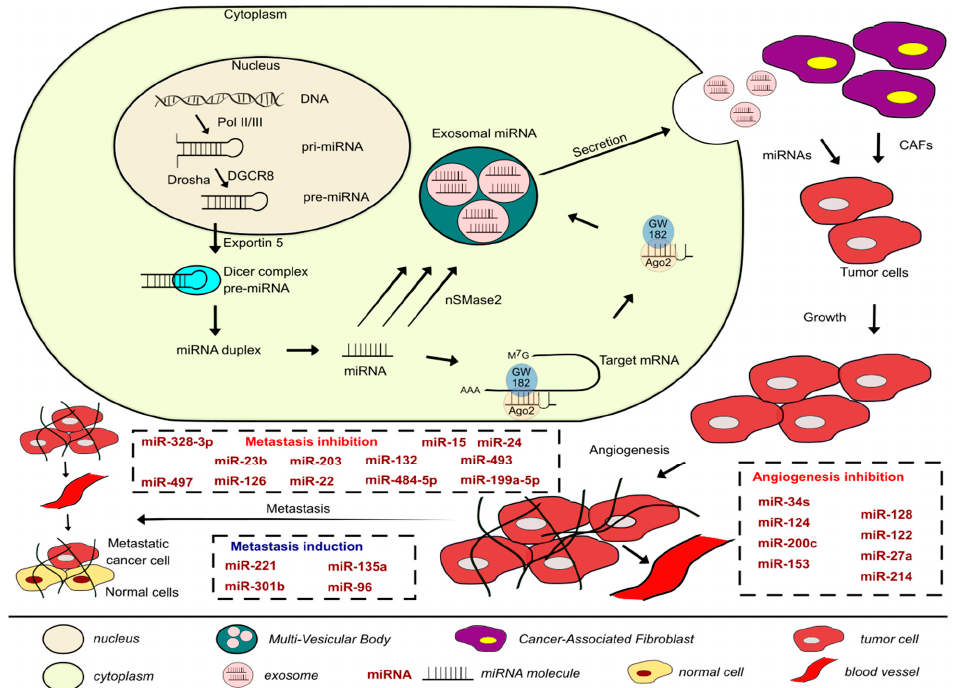
Figure 1. Development of the metastatic cascade in BLCAs along with the miRNAs involved in inhibiting or promoting the process covered in this paper and a brief description of the biogenesis, packaging, and secretion of exosomal miRNAs.